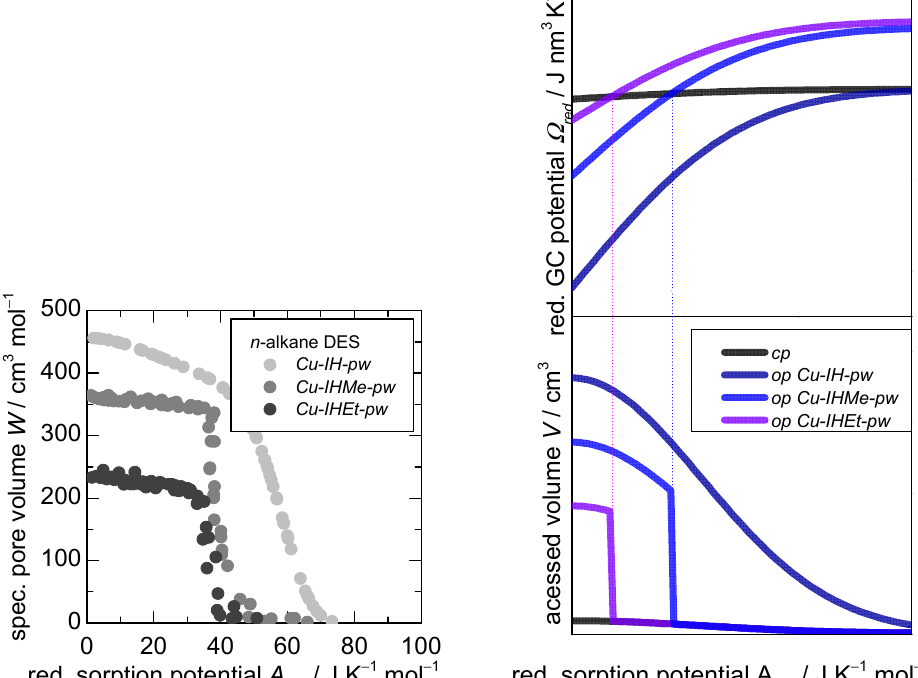
Figure 7. Bottom-left — D-UAT plot for the n -alkane desorption from experimental data at 283, 298, and 313 K. Right side: Output of the theoretical sorption model for one closed pore structure and three open pore structures in regard to the reduced grand canonical potential Ω red ( top ) as well as accessed volume V ( bottom , leading to a D-UAT plot) in dependence of the reduced sorption potential A red . The specific inputs were chosen to reach a high resemblance between the D-UAT plot from experimental data and thus gain more insights into the material–property relationships.